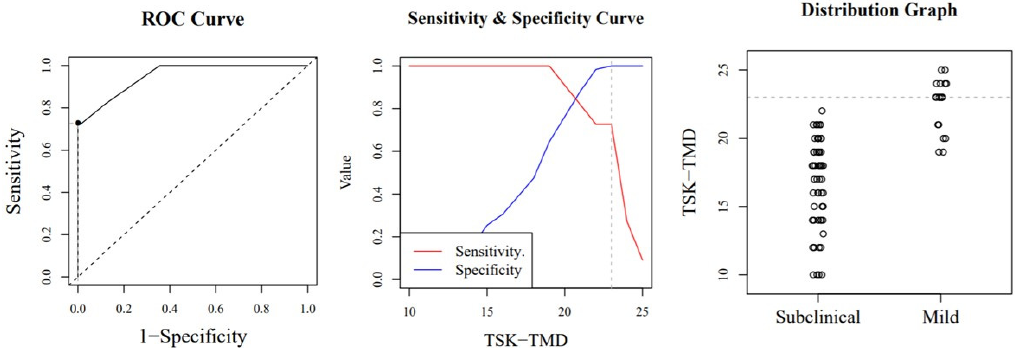
Figure A1. Optimal cut-o ff point between levels of jaw kinesiophobia. The image shows a ROC (Receiver Operating Characteristic) curve that represents the sensitivity of a diagnostic test that produces continuous results, depending on false positives (complementary to specificity), for di ff erent cut-o ff points (image on the left ), the image where the cut-o ff point at which the highest sensitivity and specificity is achieved (image in the middle ) and finally, a subclinical and mild sample distribution graph (image on the right ).